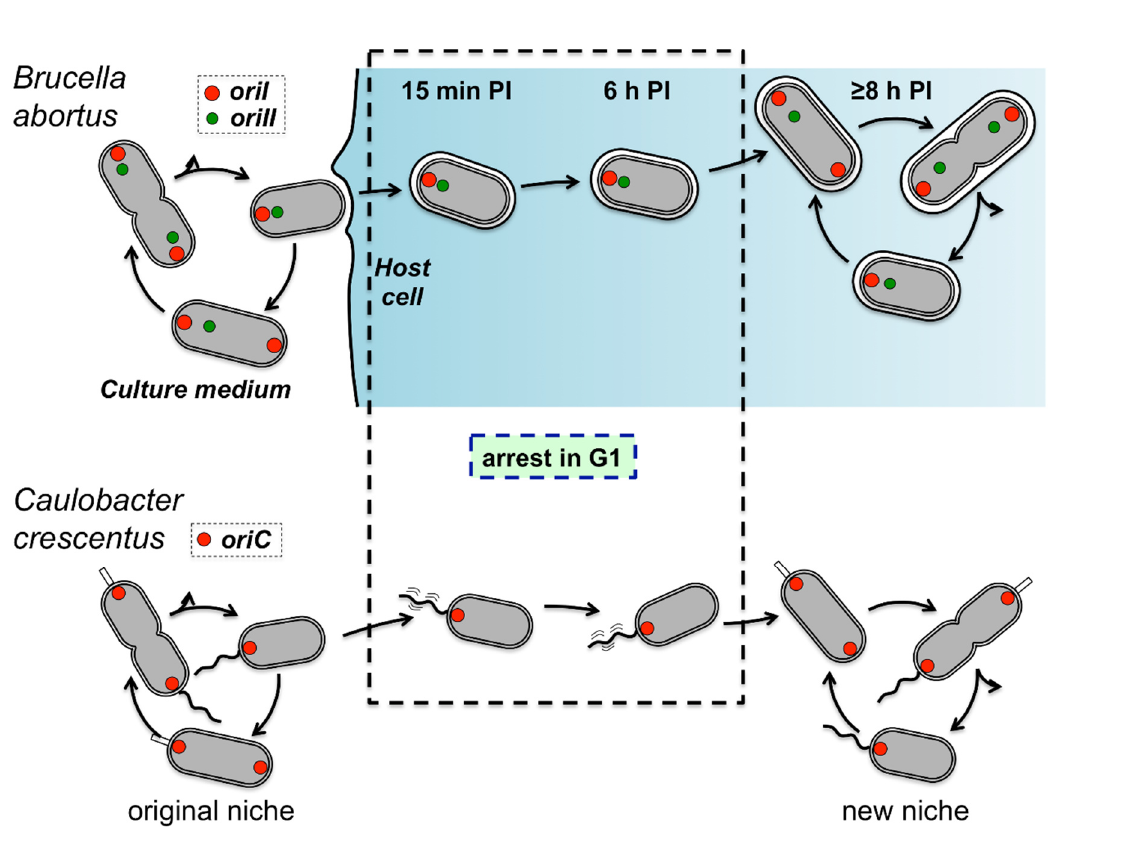
FIGURE 1: Comparison of B. abortus and C. crescentus cell cycle controls according to their lifestyle. The B. abortus replication origins of chromosome I ( oriI ) and chromosome II ( oriII ) are shown in red and green, respectively. The replication origin of the unique chromosome of C. crescentus ( oriC ) is shown in red. B. abortus duplicates its oriI before replication an segregation of its oriII . Inside host cells, at 15 min until 6 h post-infection (PI), the bacteria are mainly in G1 since unique spots of oriI and oriII are observed. This G1 arrest is similar to the G1 ar- rest observed in swarmer cells of C. crescentus . Thanks to their unique polar flagellum, the swarmer cells are able to move from an original niche to a new niche, in which nutrients are more abundant. In the original niche, the stalked cells are immobilized because they stick to a substrate, thanks to the holdfast at the end of their stalk (small white rectangle). In the case of B. abortus , the ER could be considered as a new niche in which nutrients are abundant, since this pathogen massively replicates in this